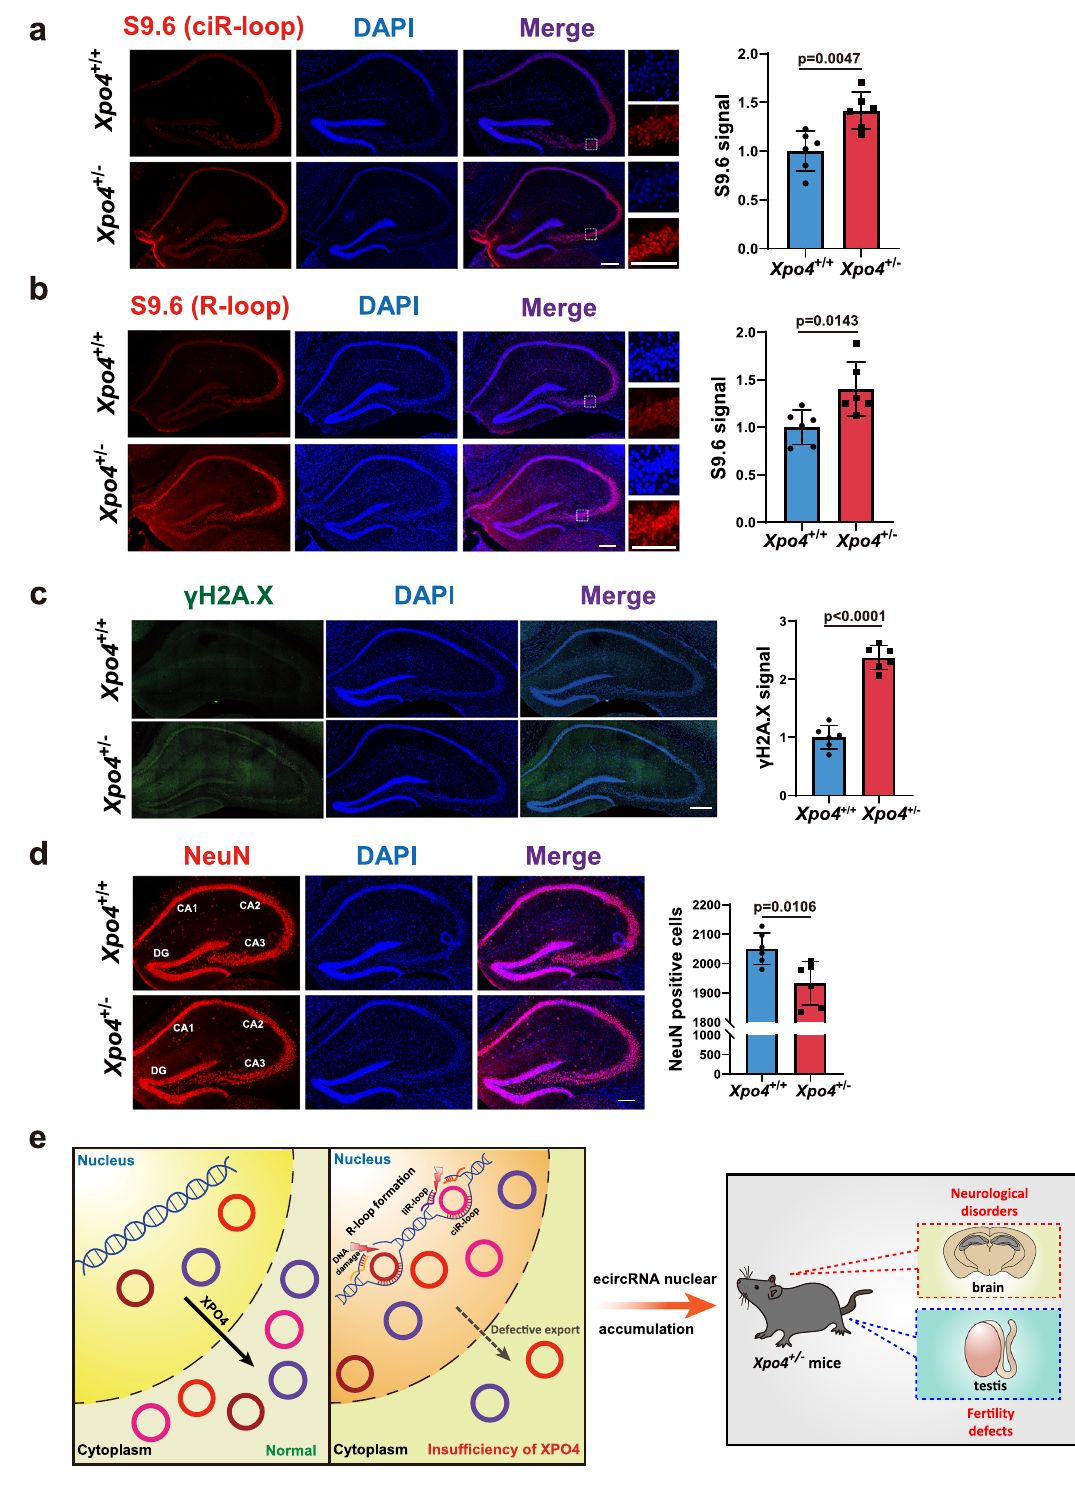
Fig. 6 | Insuf fi cient XPO4 dosage causes neurological de fi cits in Xpo4 +/ − mice. a Representative IF images with enlarged regions of ciR-loop in the hippo- campus of Xpo4 +/+ and Xpo4 +/ − mice. Quanti fi cations are shown (DAPI, blue; R- loop, red). n = 6 for both Xpo4 +/+ and Xpo4 +/ − . b Representative IF images with enlarged regions of R-loop in Xpo4 +/+ and Xpo4 +/ − mice. Quanti fi cations are shown(DAPI,blue;R-loop,red). n = 6forboth Xpo4 +/+ and Xpo4 +/ − . c IFof γ H2A.X (DNA damage) in the hippocampus of Xpo4 +/+ and Xpo4 +/ − mice. Representative imagesandquanti fi cationareshown(DAPI,blue;DNAdamage,green). n = 6for both Xpo4 +/+ and Xpo4 +/ − . d IF of NeuN, a neuronal marker, in the hippocampus of Xpo4 +/+ and Xpo4 +/ − mice. Representative images and quanti fi cation are